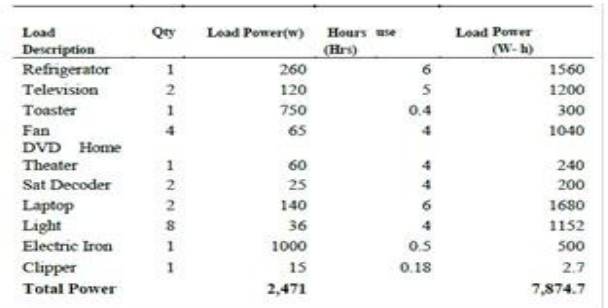
The residence under consideration consumes an approximate electrical load of 7.875kWh/day of electricity and daily watt power of